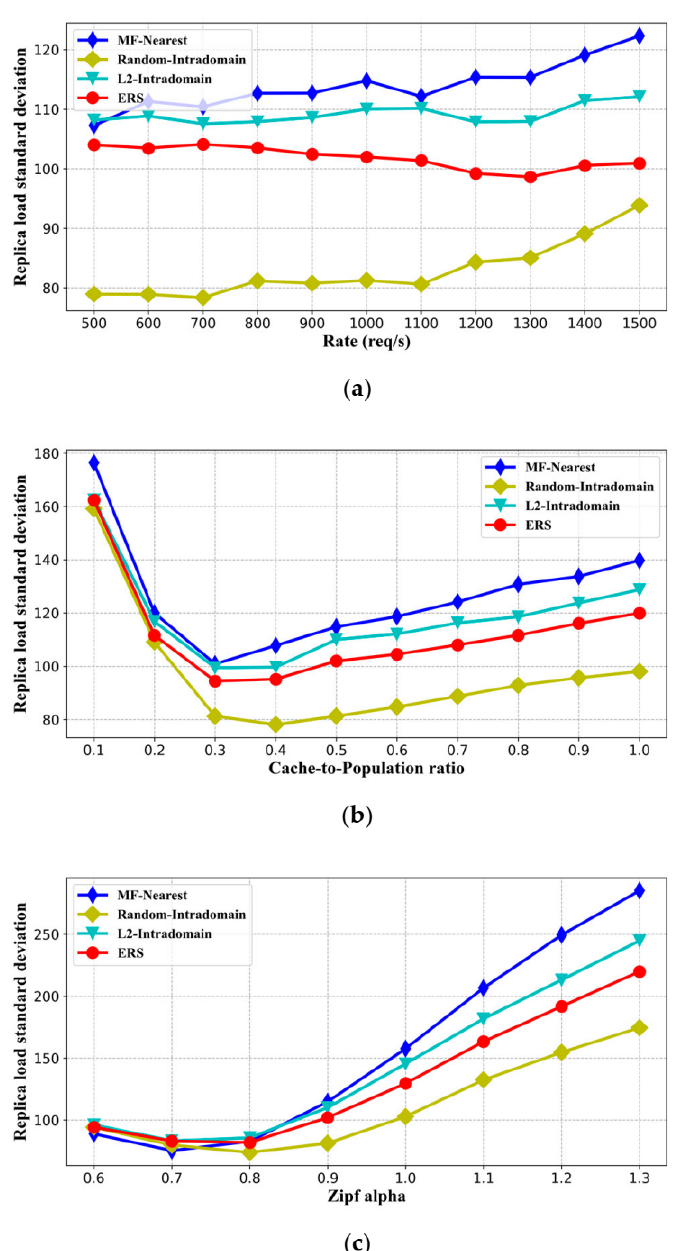
Figure 7. The standard deviation of replica node load comparison with different impact factors. ( a ) Request rate, ( b ) cache-to-population ratio, and ( c ) Zipf parameter